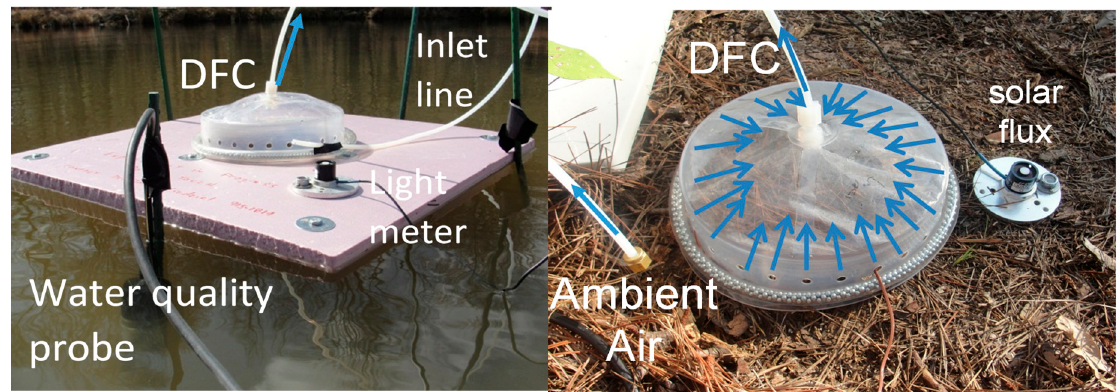
Figure 1. Photos showing the dynamic flux chamber for air / water and soil / air measurements. Also shown is the direction of air flow, light meter, ambient air inlet and YSI water quality probe.